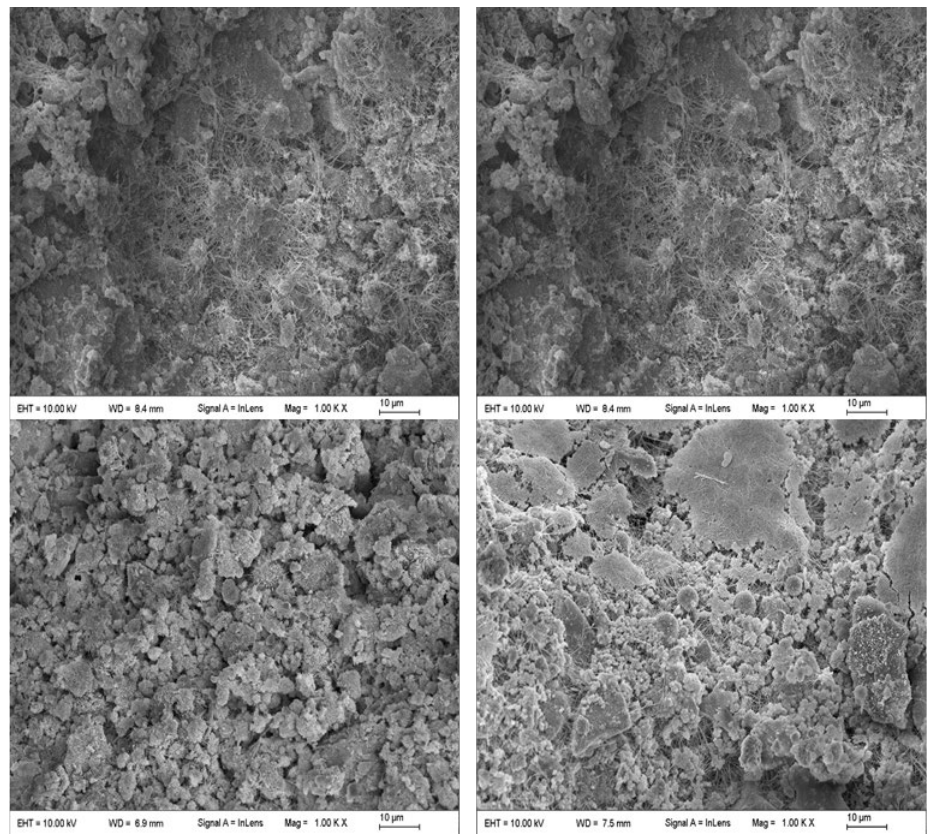
Figure 11. Microstructure diagram of CSM with 100% RMA at 7 d under different fly ash replacement rates (×1000). (Note: the upper left is CF0, the upper right is CF1, the lower left is CF2, the lower right is CF3).